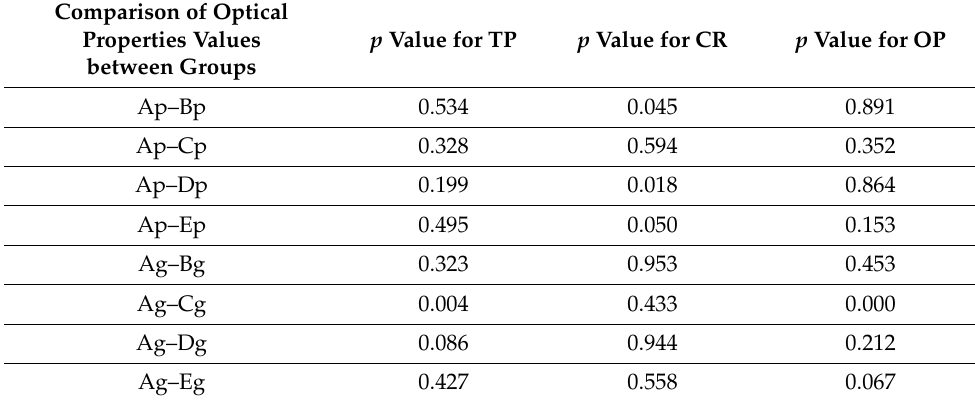
Table 4. p values between groups, related to optical properties.